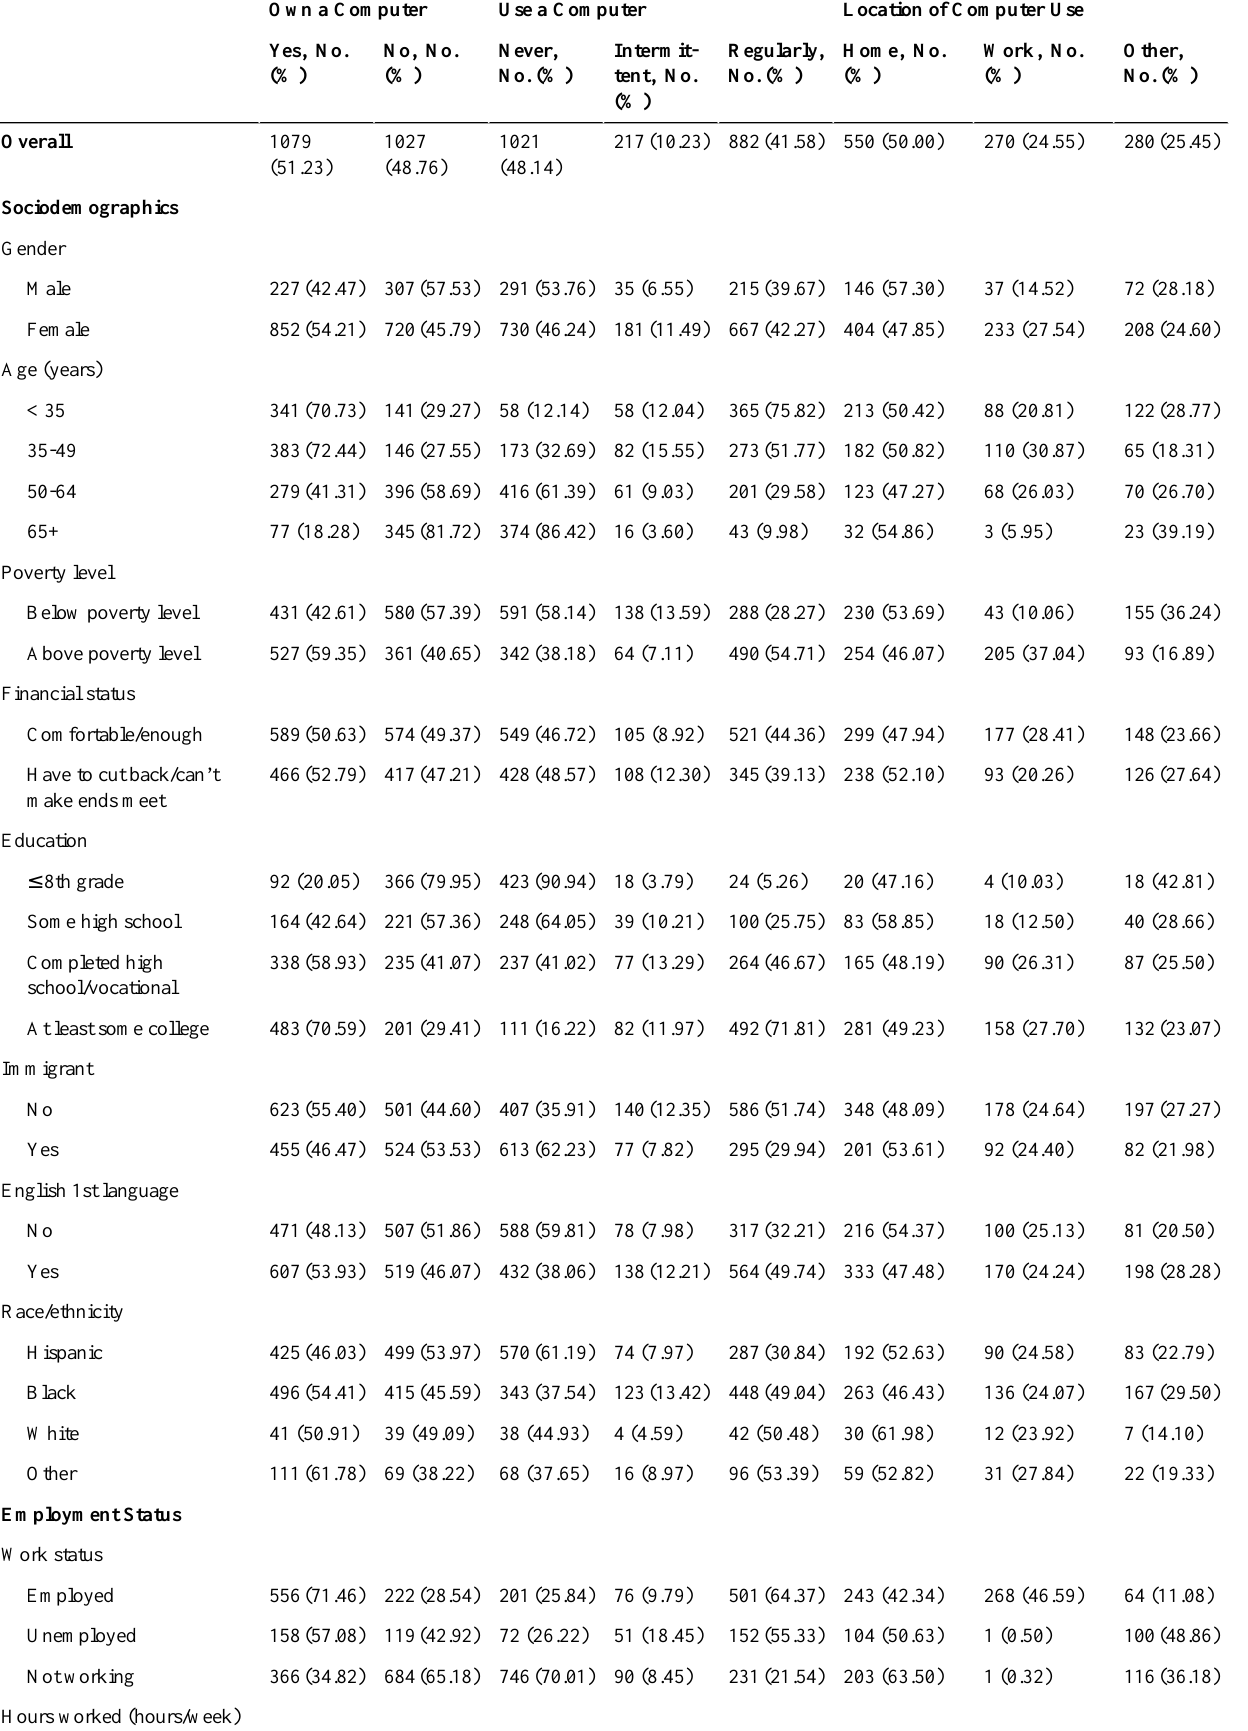
Table 1. Computer use weighted frequencies